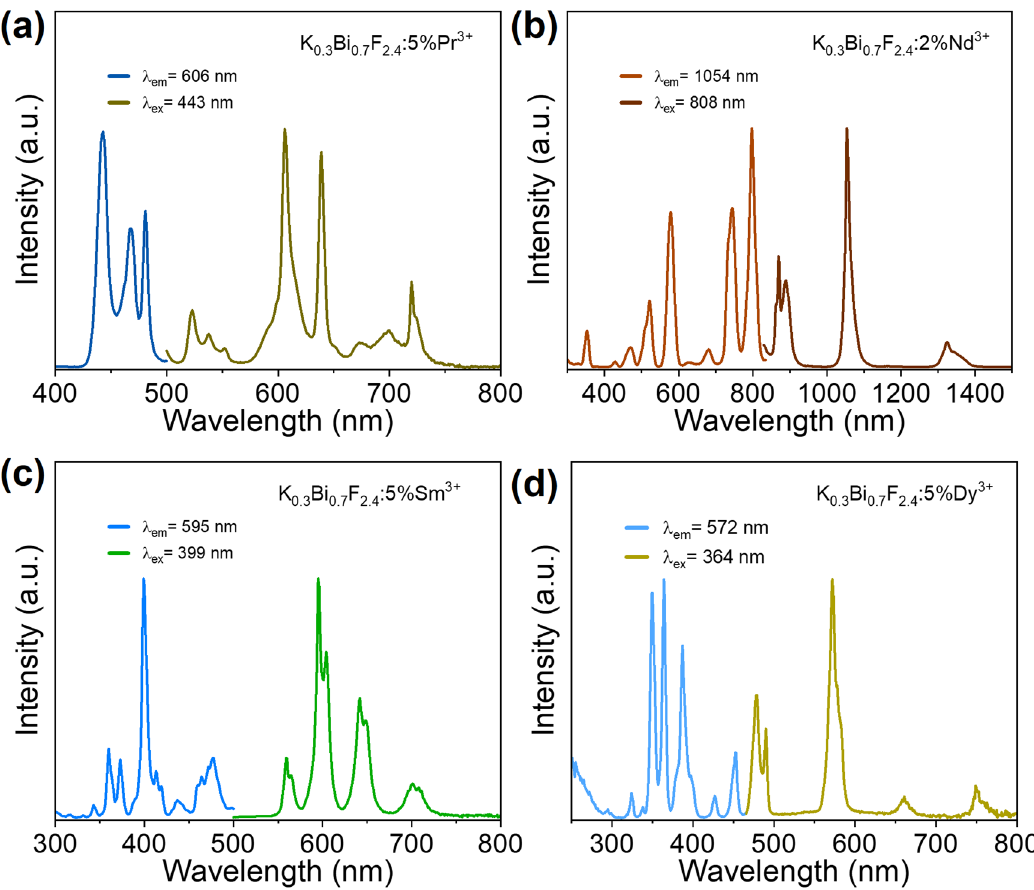
Figure 7. Photoluminescence properties of KBF:Ln (Ln = Pr, Nd, Sm, Dy) nanocrystalline particles ( a – d